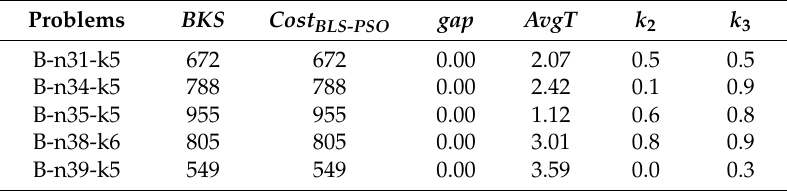
Table 5. Performance of BLS-PSO in solving the benchmark problems in Set